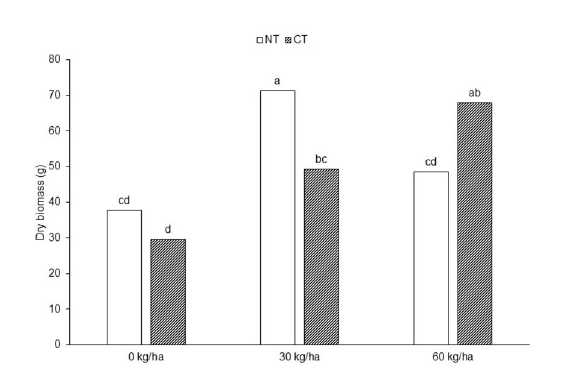
FIGURE3 Interactive effects of fertilizer and tillage on dry biomass on a soybean cropping system. Levels with same letter are not significantly